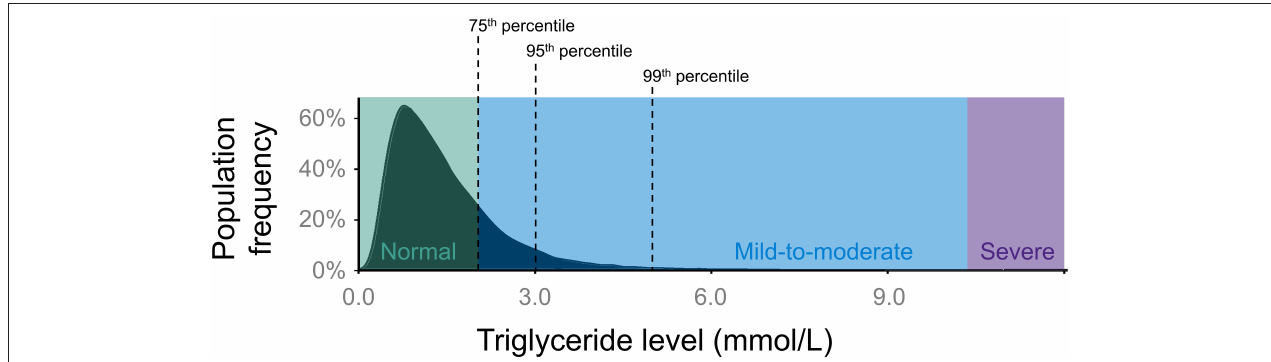
FIGURE 1 | Population distribution of plasma TG levels. The distribution of TG levels has a positive (right) skew in the general population. In this review, normal TG levels are considered as < 2.0 mmol/L (175 mg/dL), while anything above normal can be classified as hypertriglyceridemia. “Mild-to-moderate” hypertriglyceridemia is defined as 2.0–9.9 mmol/L (175–885 mg/dL), while “severe” hypertriglyceridemia is defined as ≥ 10.0 mmol/L ( ≥ 885 mg/dL). Severe hypertriglyceridemia can be further defined as FCS or MCM, depending on its genetic basis. The black dashed lines indicate the 75th percentile (2.0 mmol/L), 95th percentile (3.0 mmol/L), and 99th percentile (5.0 mmol/L) for TG levels. FCS, familial chylomicronemia syndrome; MCM, multifactorial chylomicronemia; TG,